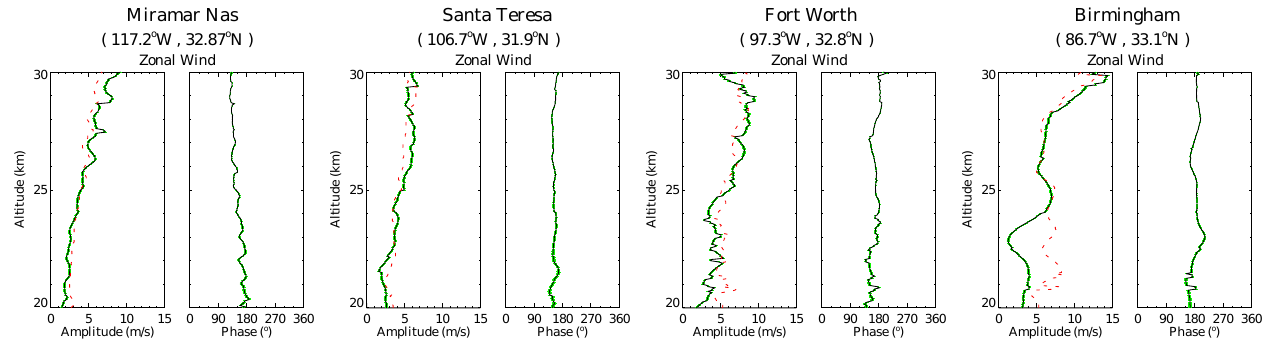
Fig. 9. The harmonic fitting results for the quasi 16-day waves of zonal wind disturbances during December 2000 within 20–30km. The green lines in every 100m in height denote the error bar. Table 2. Propagation parameters of quasi 16-day wave for zonal wind component in stratosphere. Stations Phase difference Zonal distance Propagation velocity Wave